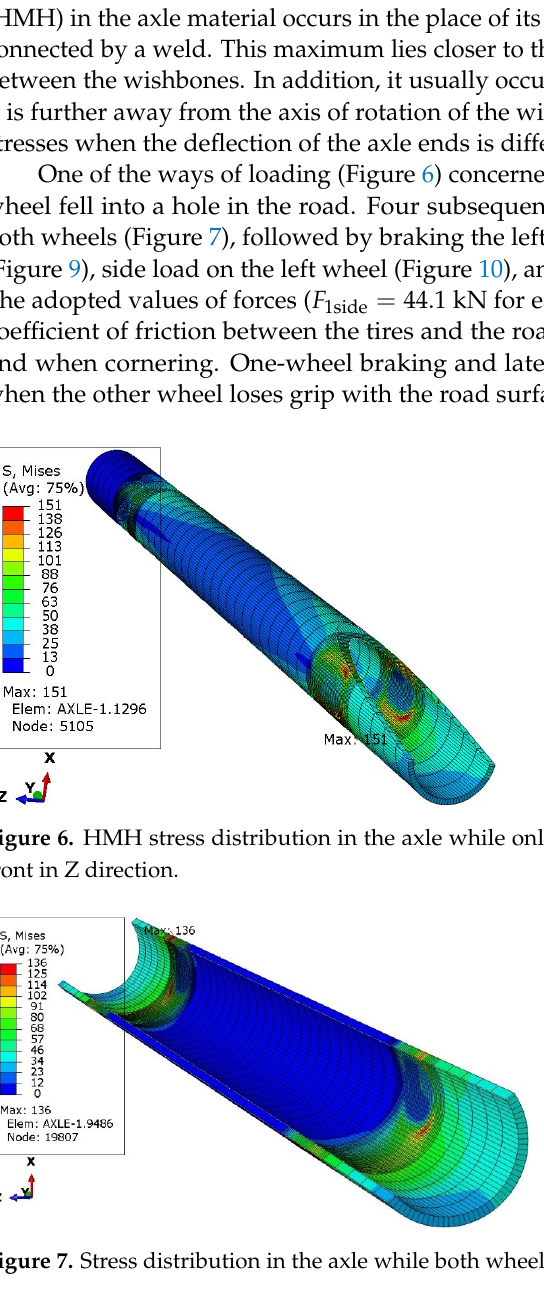
Figure 8. Stress distribution in the axle while only left wheel break is active. Figure 9. Stress distribution in the axle while only both wheels break. Figure 10. Stress distribution in the axle and max strengthen node 4384 while side force during turning acts to the left wheel.